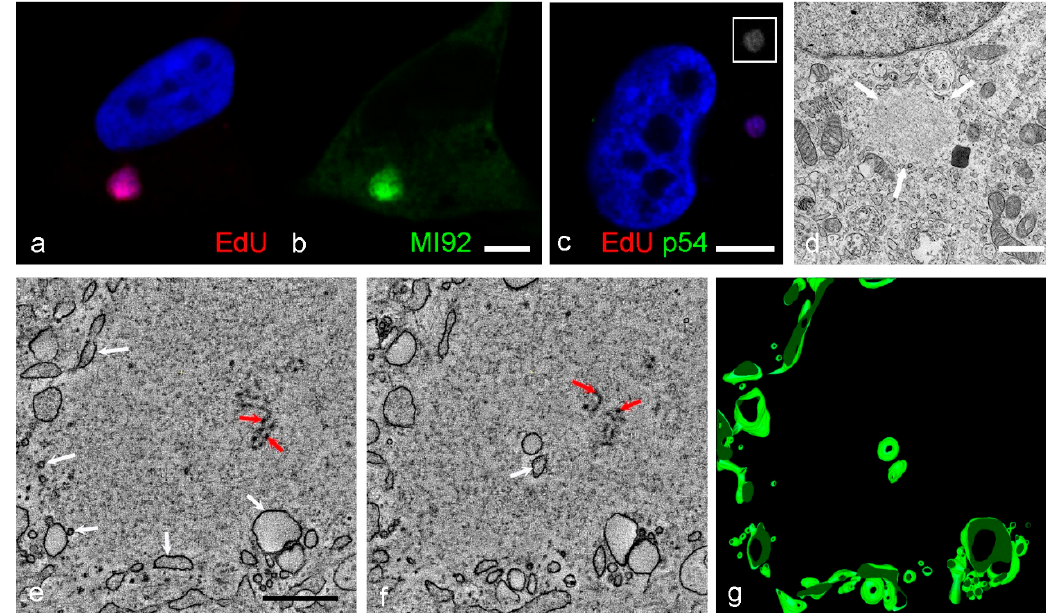
Figure 8. Early ASFV factories seen by confocal and electron microscopy. ( a , b ) Vero cells infected for 10 h had EdU incor- porated into newly synthesized DNA, labelled with AlexaFluor 555 which localized to the viral factory. Labelling with an anti-ASFV serum (MI92) and AlexaFluor 488 highlighted the presence of viral protein, although this was shown not to be the intermediate protein p54 as anti-p54 antibody labelling (green) was negative at this early stage in infection ( c ). Area in the white box is a greyscale conversion (brightness enhanced) of the EdU labelling which is faint, but present. Cells infected for 12 h were prepared for TEM by chemical fixation. Cellular components have been cleared from an early factory ( d , white arrows) although tomographic reconstruction (Video S4) of a different factory from the same sample shows an accumulation of vesicles at the periphery ( e , white arrows), two vesicles near the factory center ( f , white arrow) and, separately, a small number of membrane fragments ( e , f , red arrows). Vesicles are depicted in the model taken from this reconstruction ( g ). Scale bars: b, c = 5 μ m, d = 1 μ m, e = 500 nm.